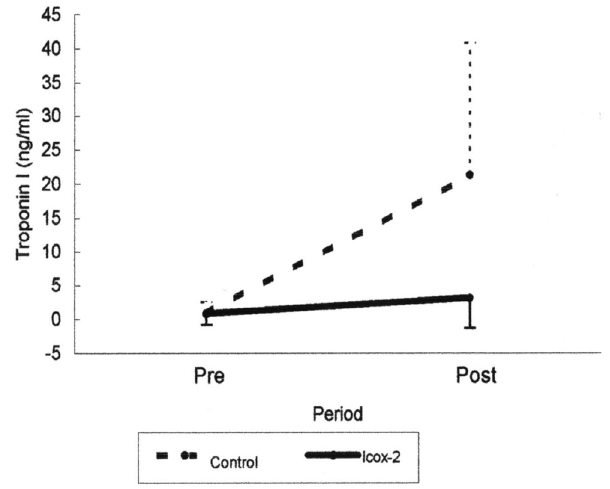
Figure 3 - Graph showing values of Troponin I during the pre and post- infarction periods in the control dogs and in the dogs treated with